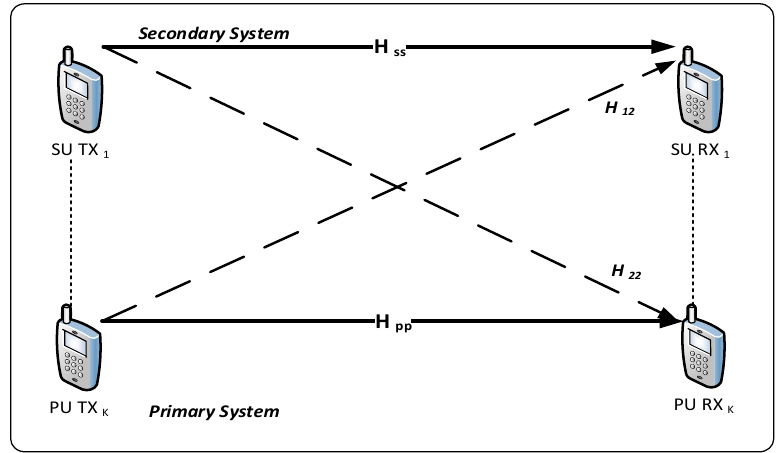
Figure 5. Single user multiple-input multiple-output (MIMO) link.